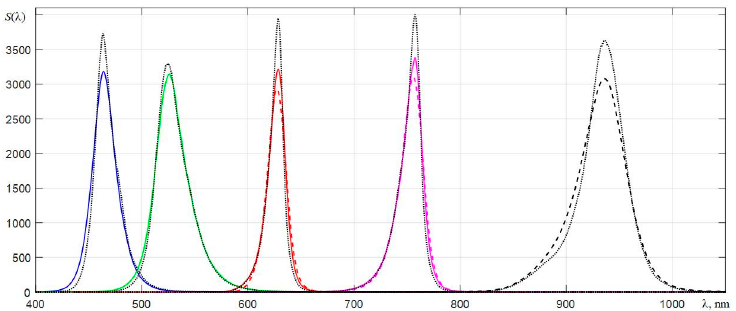
Figure 11. Normalized spectra of LEDs, which are registered using the AvaSpec 2048L (dotted lines), C12880MA (solid lines), and C11708MA (dashed lines) spectrometers.